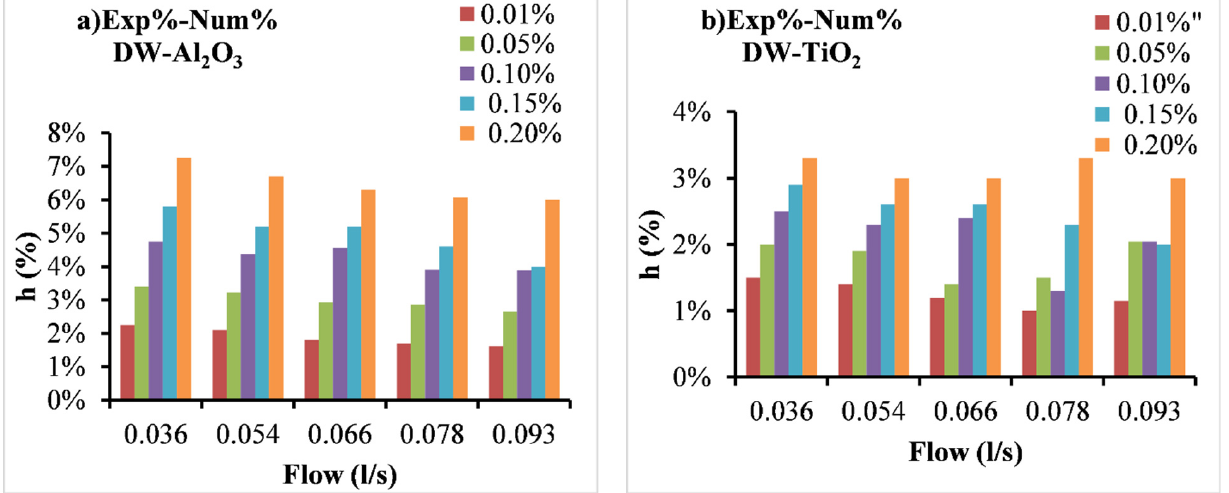
Figure 9. The deviation between experimental (Exp) and numerical (Num) findings of the enhance- ment of CHTC (h%) as a function of flow rate of ( a ) Al 2 O 3 and ( b ) TiO 2 NFs.